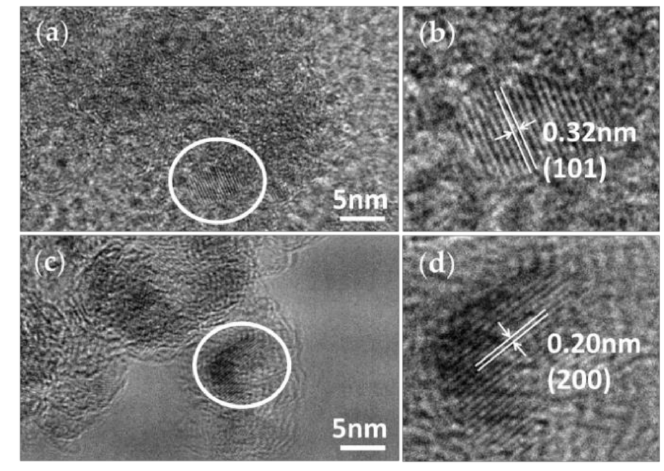
Figure 7. HRTEM images of ( a ) C / TiO 2 aerogel and ( c ) TiC / C aerogel with ( b , d ) the magnified images of the corresponding selected areas in the white